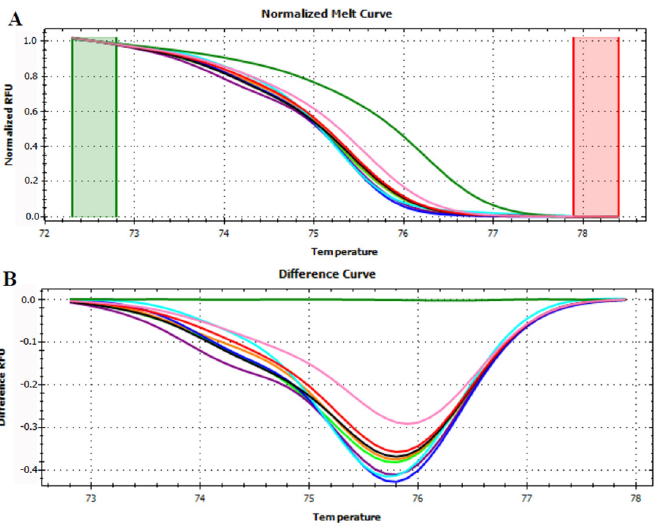
Figure 4. Normalized melt curve ( A ) and difference curve ( B ) of HRMA of P6 loop of trnL (UAA) intron on apple and pear mixed juices. Apple fruit: red, pear fruit: pink, apple/pear juices 99.5%/0.5%: black, 99%/1%: light blue, 95%/5%: blue, 90%/10%: purple, 75%/25%: orange and 50%/50%: light green. Reference cluster is kiwi fruit: green. The HRMA has been carried out on three independent replicates of each sample and the most representative curve of each sample is reported in the graph.